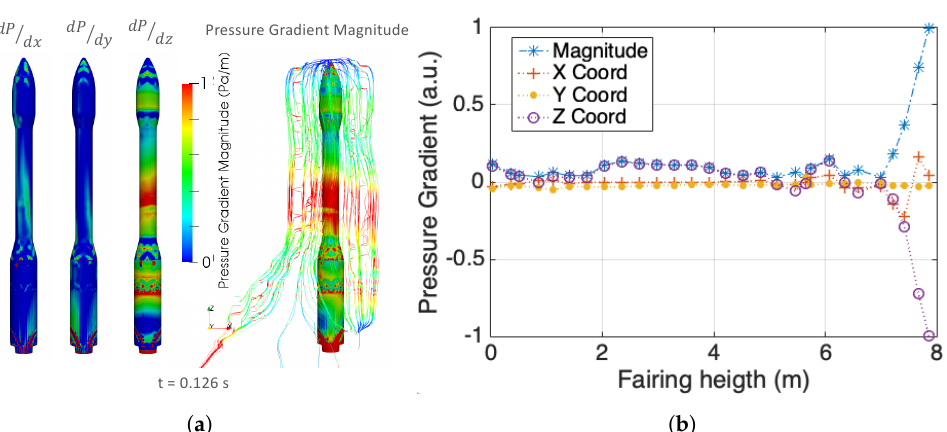
Figure 7. Pressure gradient magnitude and components. ( a ) Graphical representation at t = 0.126 s. ( b ) Plot over the fairing axial